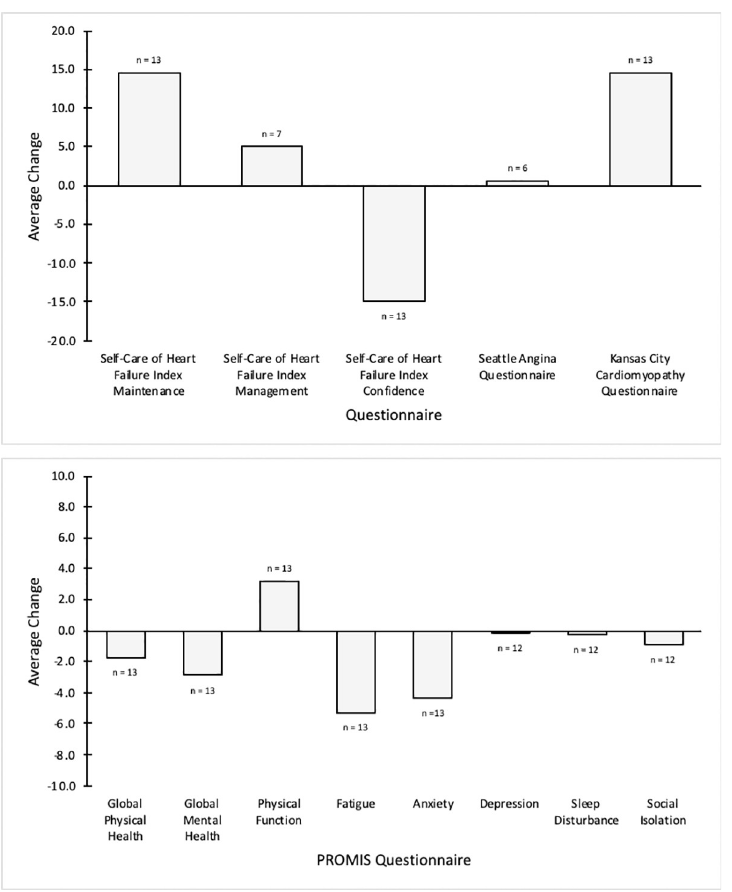
Fig 1. Average changes in patient-reported outcomes. For non-PROMIS questionnaires, a positive change indicates improvement in health status. A positive change also signifies improvement in health status for the following PROMIS questionnaires: Global Physical Health, Global Mental Health, and Physical Function. Conversely, a negative change is indicative of improvement in health status for the following PROMIS questionnaires: Fatigue, Anxiety, Depression, Sleep Disturbance, and Social